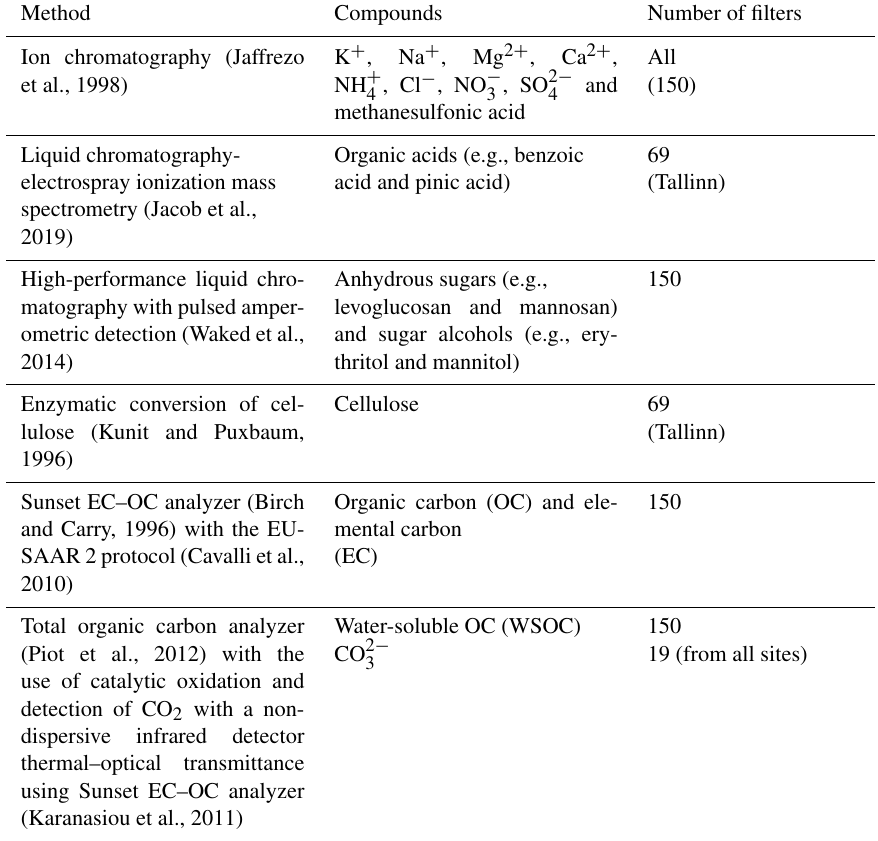
Table 1. Detailed overview of the additional measurements. Method